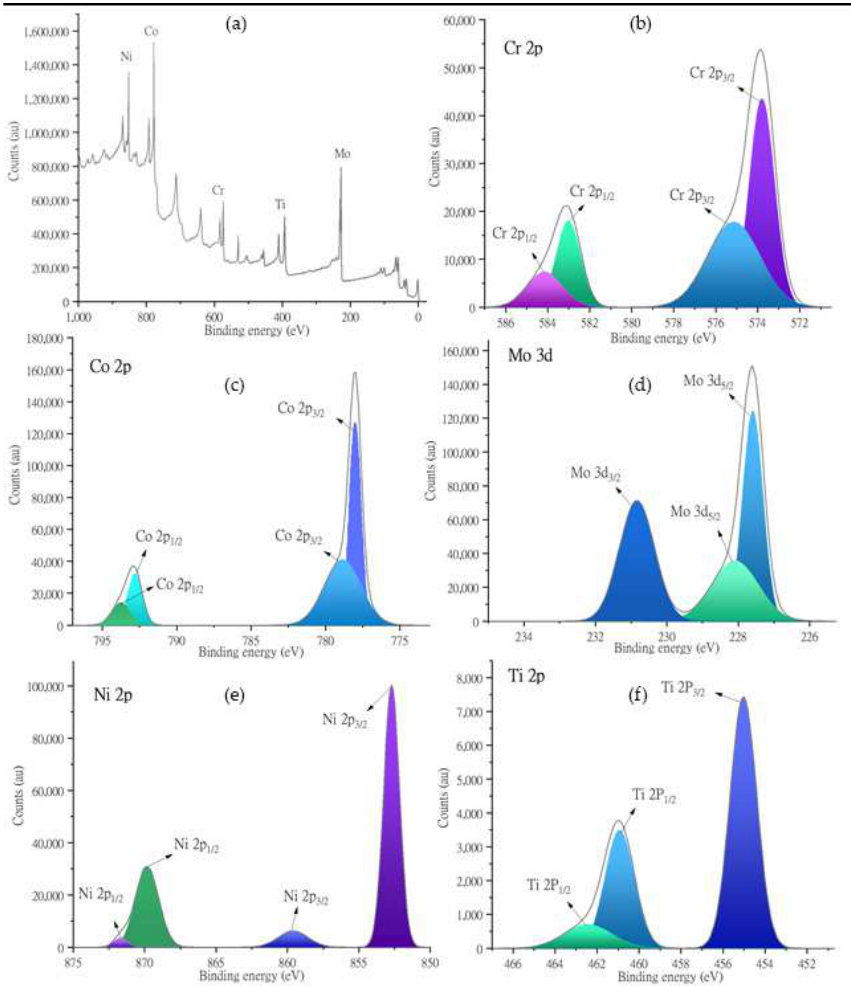
Table 2. Electrochemical properties of HEA with reference to uncoated titanium CP-II.